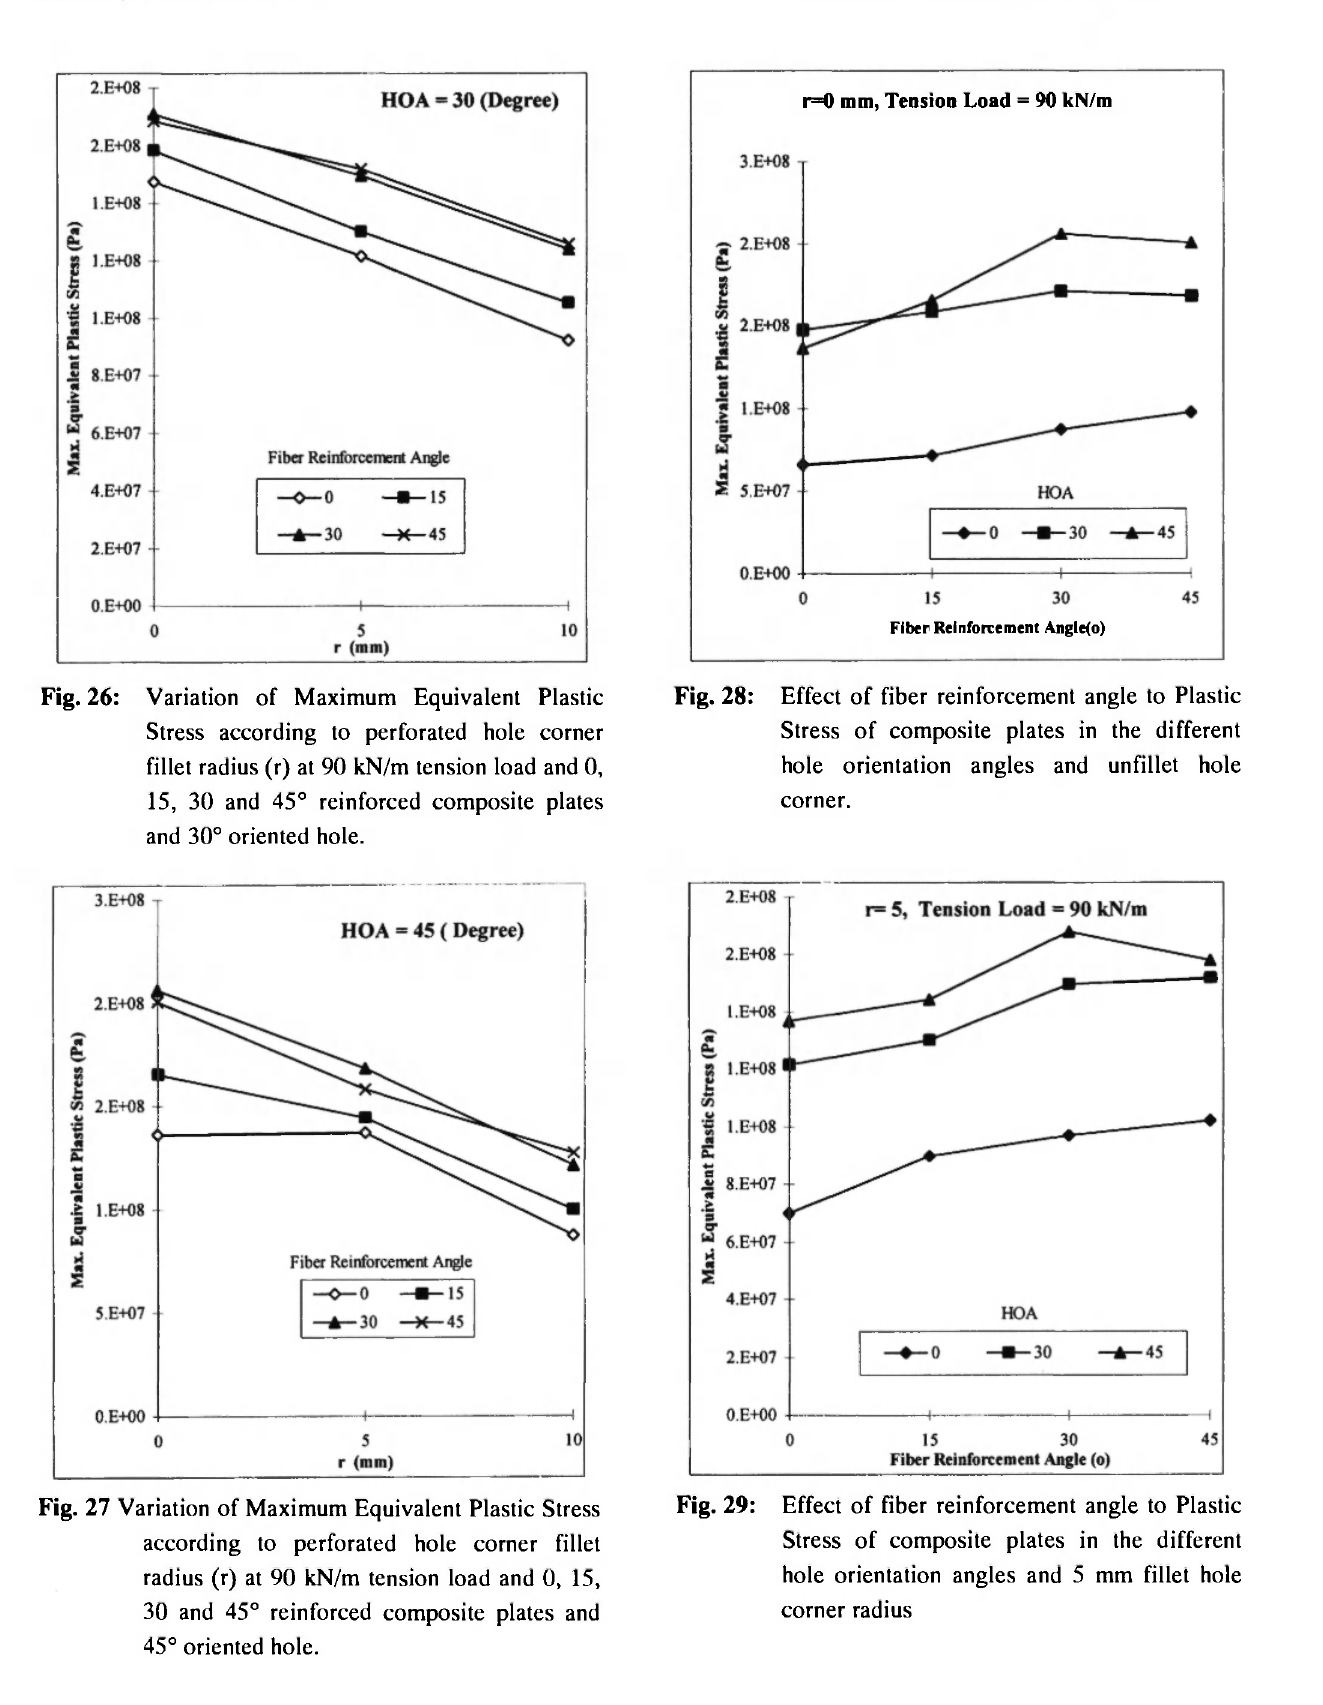
Fig. 27 Variation of Maximum Equivalent Plastic Stress according to perforated hole corner fillet radius (r) at 90 kN/m tension load and 0, 15, 30 and 45° reinforced composite plates and 45° oriented hole.